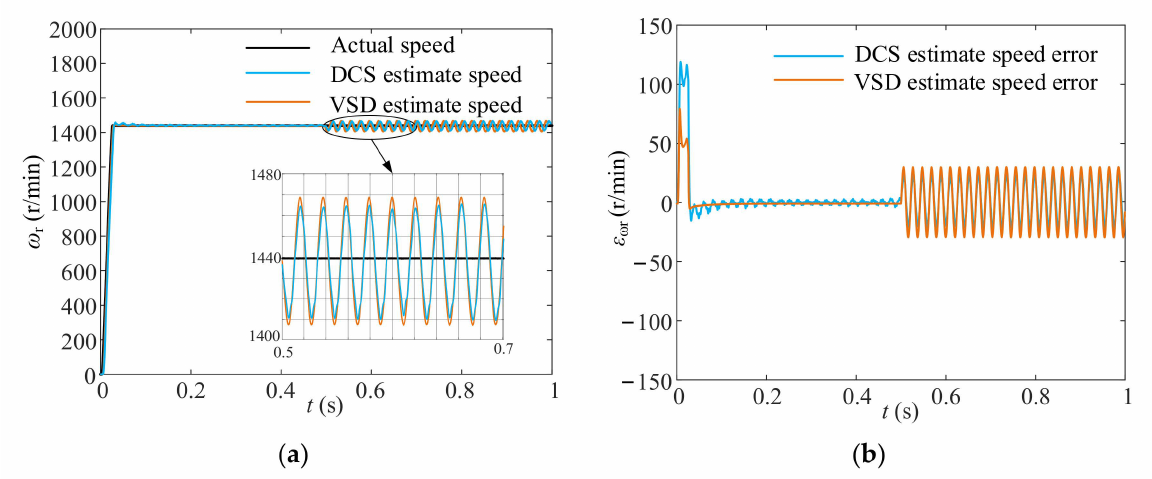
Figure 15. Speed-estimation results without stator resistance identification. ( a ) Speed; ( b ) Speed